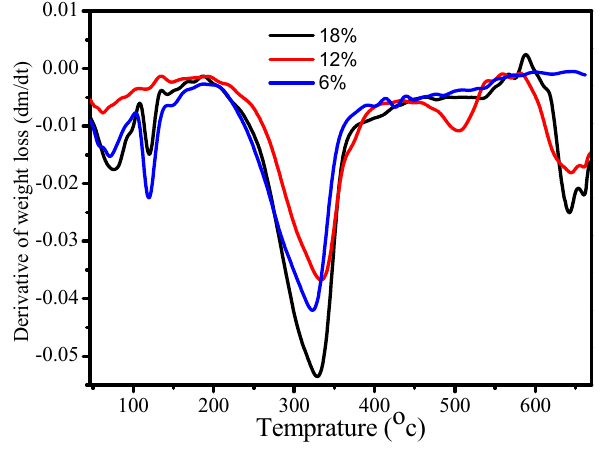
Fig. 5 DTG analysis of alkali-treated Y.alpina bamboo fiber with var- ious NaOH